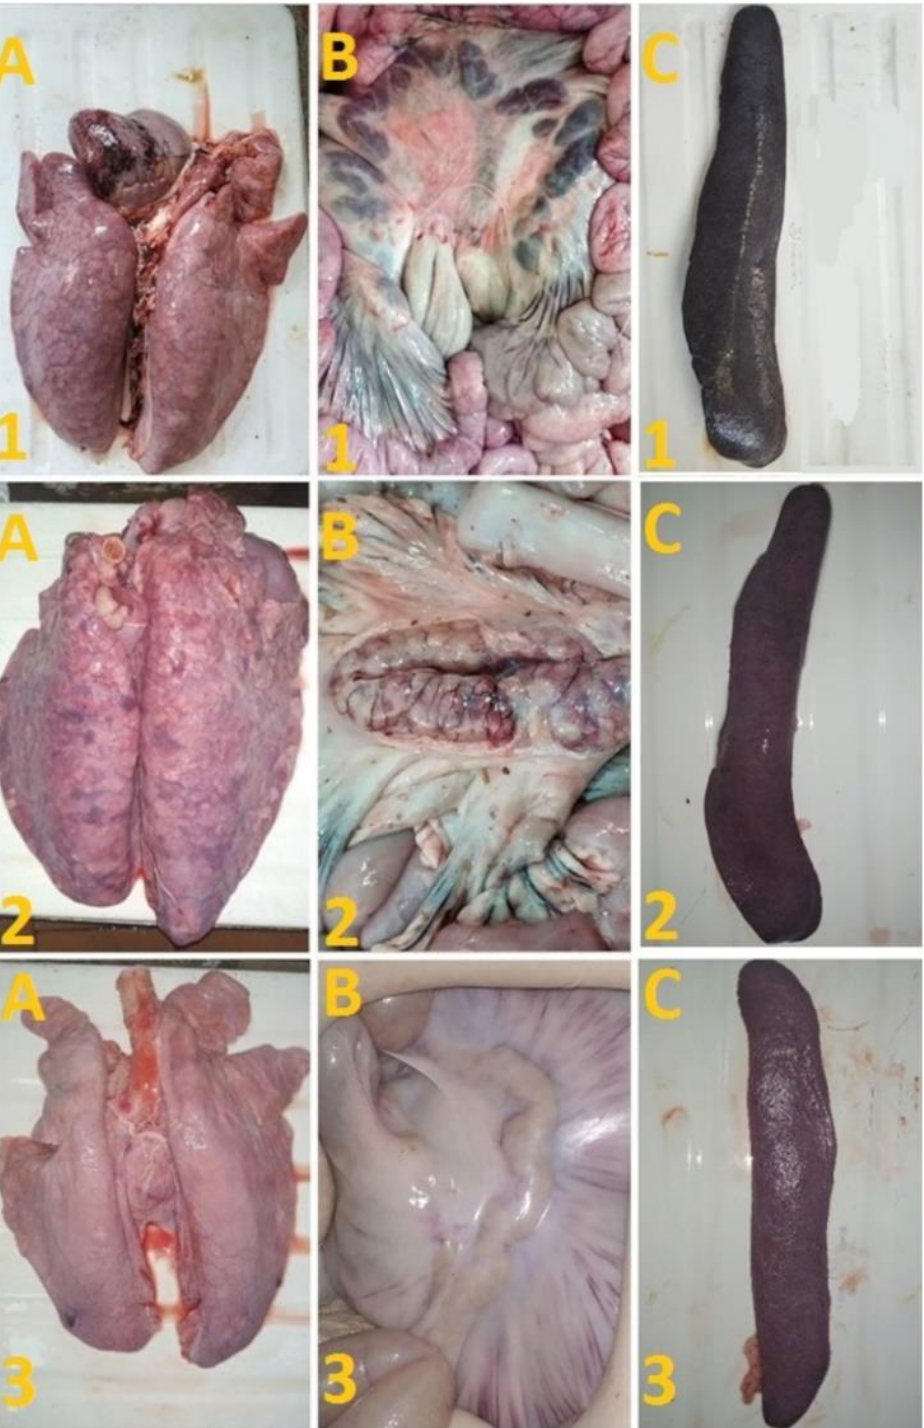
Figure 6. Lungs ( A ), mesenterial lymph nodes ( B ) and spleen ( C ) of pigs: # 1 with an acute course caused by inoculation with Katanga-350, followed by a challenge with Lisbon-57; pig # 2 with chronic form caused by inoculation with Katanga-350, and followed by a combined challenge with Lisbon-57 and Stavropol 08/01 strains; asymptomatic course of ASF (pig # 3) caused by inoculation with Katanga-350, and followed by a challenge with Lisbon-57 and Stavropol 08/01 strains